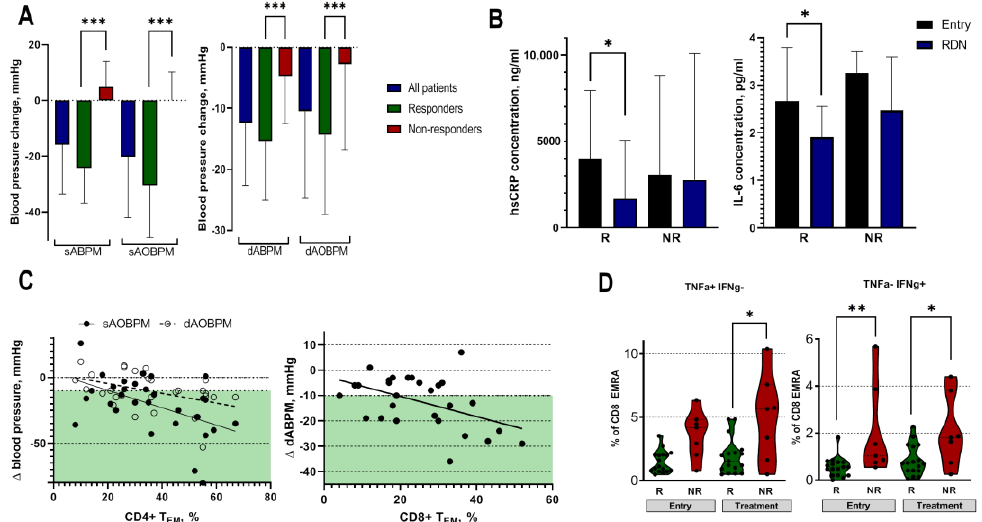
Figure 2. The effect of renal denervation procedure on blood pressure and inflammatory activity.